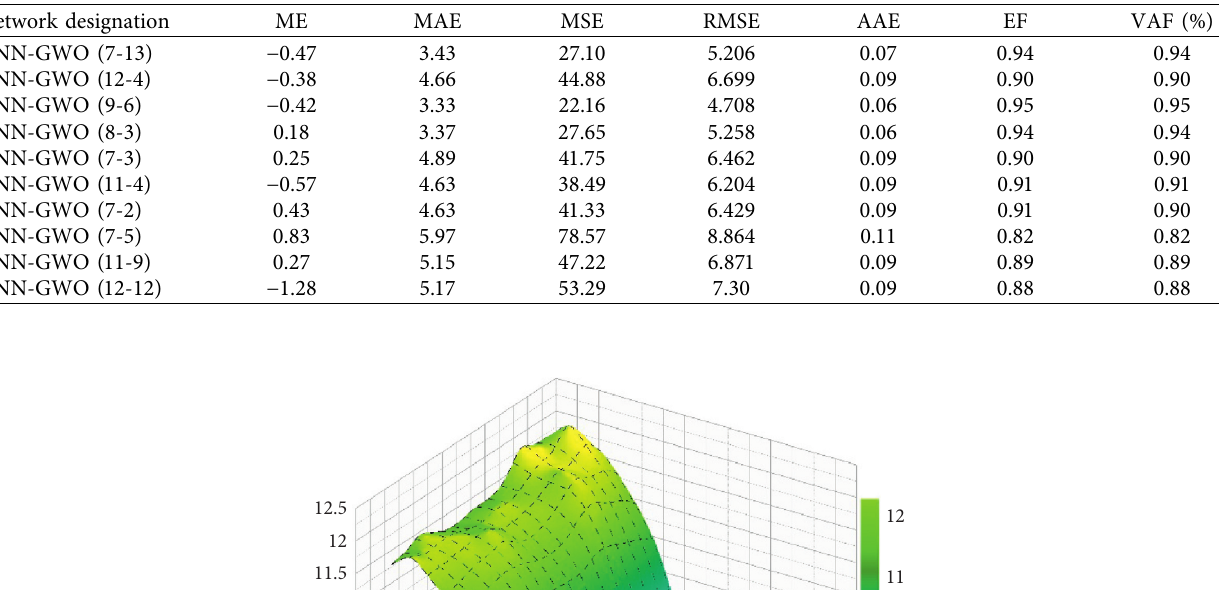
Table 5: Statistical indexes of the top 10 models in the neural networks on testing data.